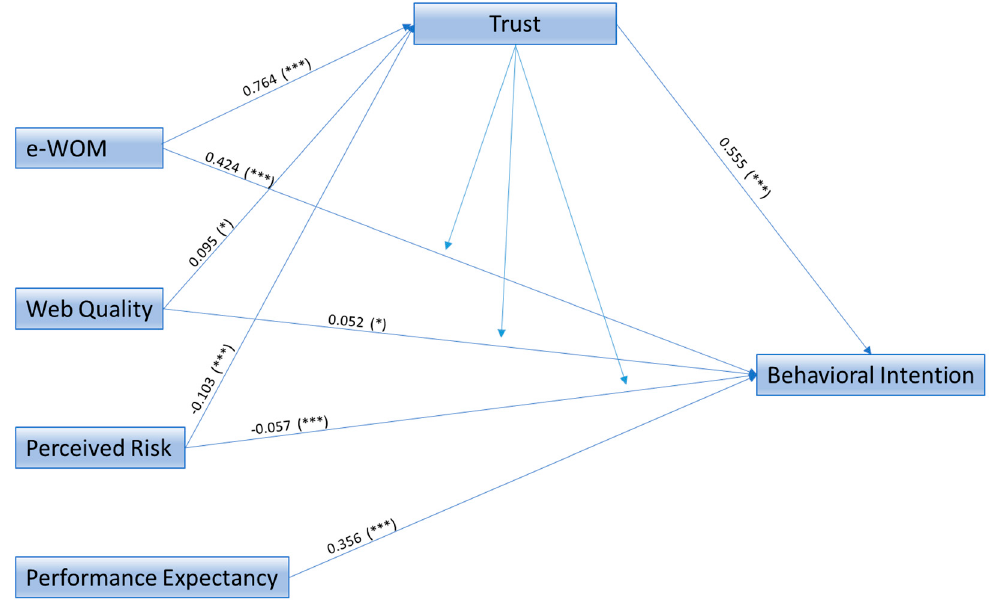
Figure 2. Results of the Proposed model. *** p < 0.001, ** p < 0.01, * p < 0.05. (based on 1 tail and bootstrap test with 5000 samples).